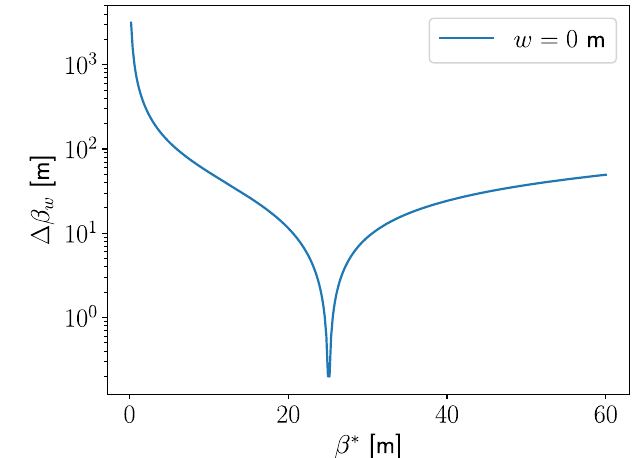
FIG. 2. Error amplification when given by Eq. (6) when β (cid:1) ≈ L (cid:1) þ L = 2 . For the LHC, L (cid:1) ¼ 23 m and L Q